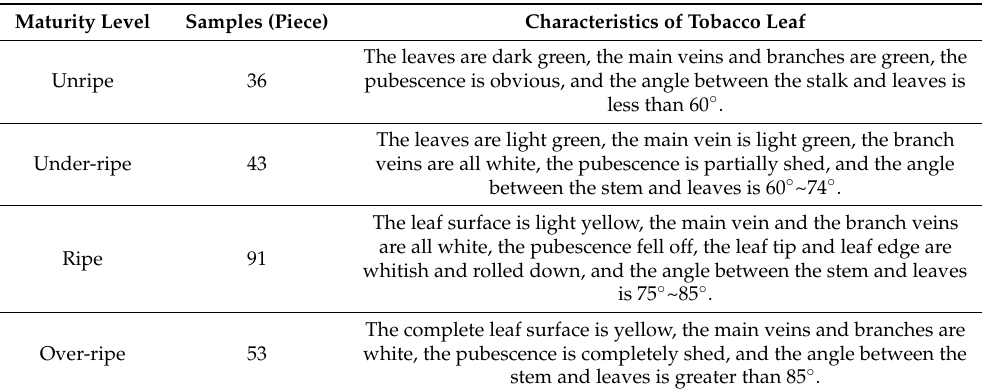
Table 1. The maturity characteristics of different flue-cured tobacco samples.